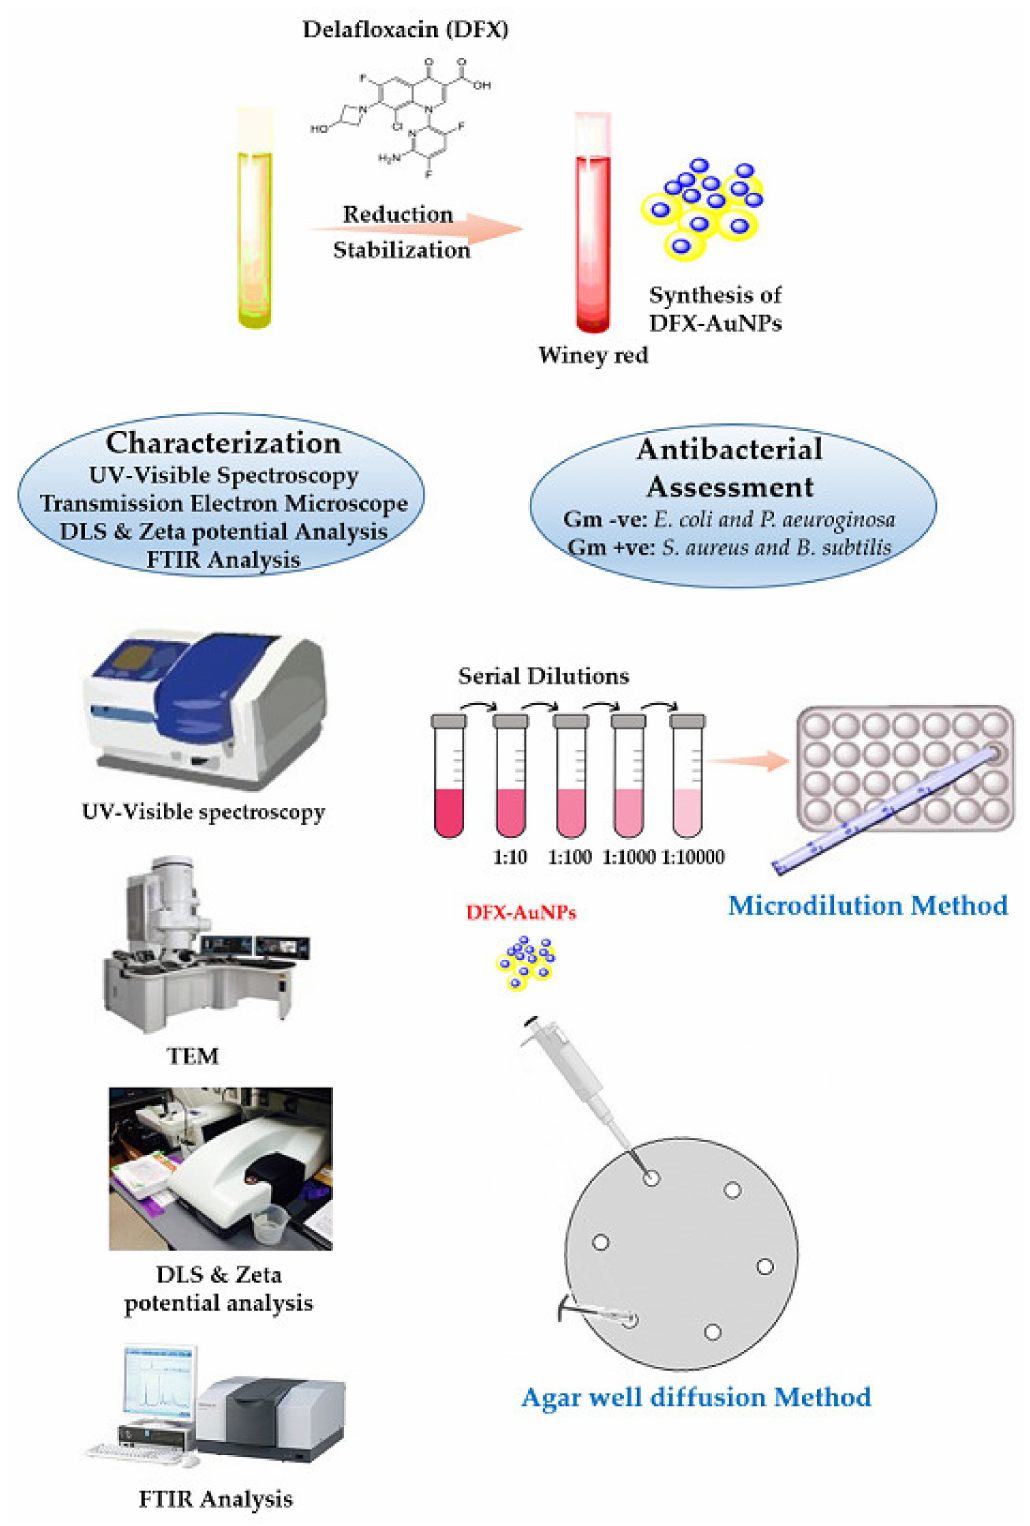
Figure 1. Schematic representation of DFX-AuNPs synthesis procedure, its characterization and antibacterial potential